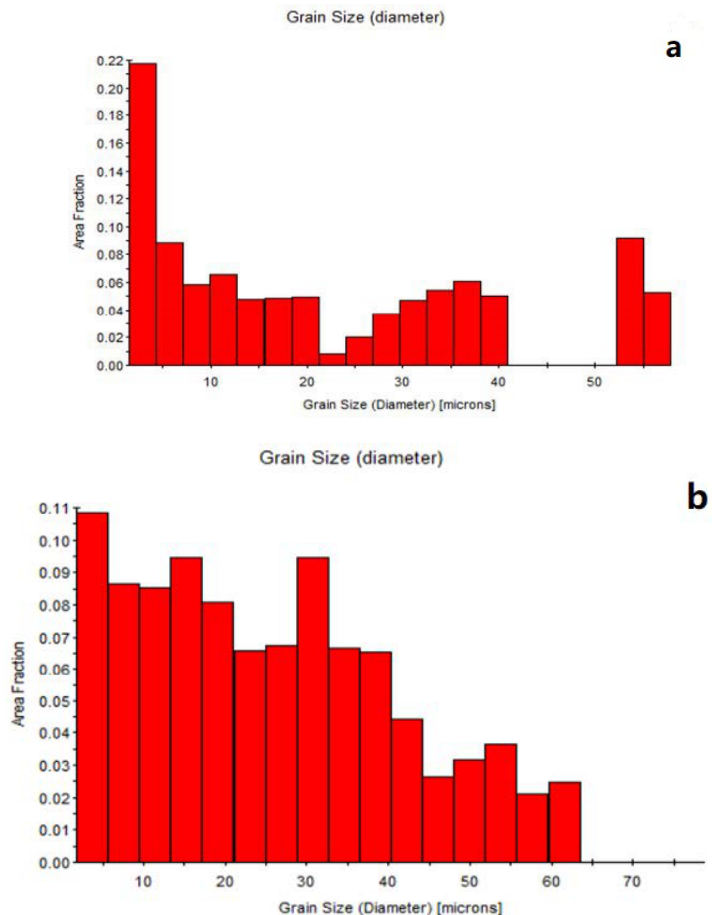
Figure 16. Grain size diameter for ( a ): 𝑇 11 ; ( b ): 𝑇 31 .